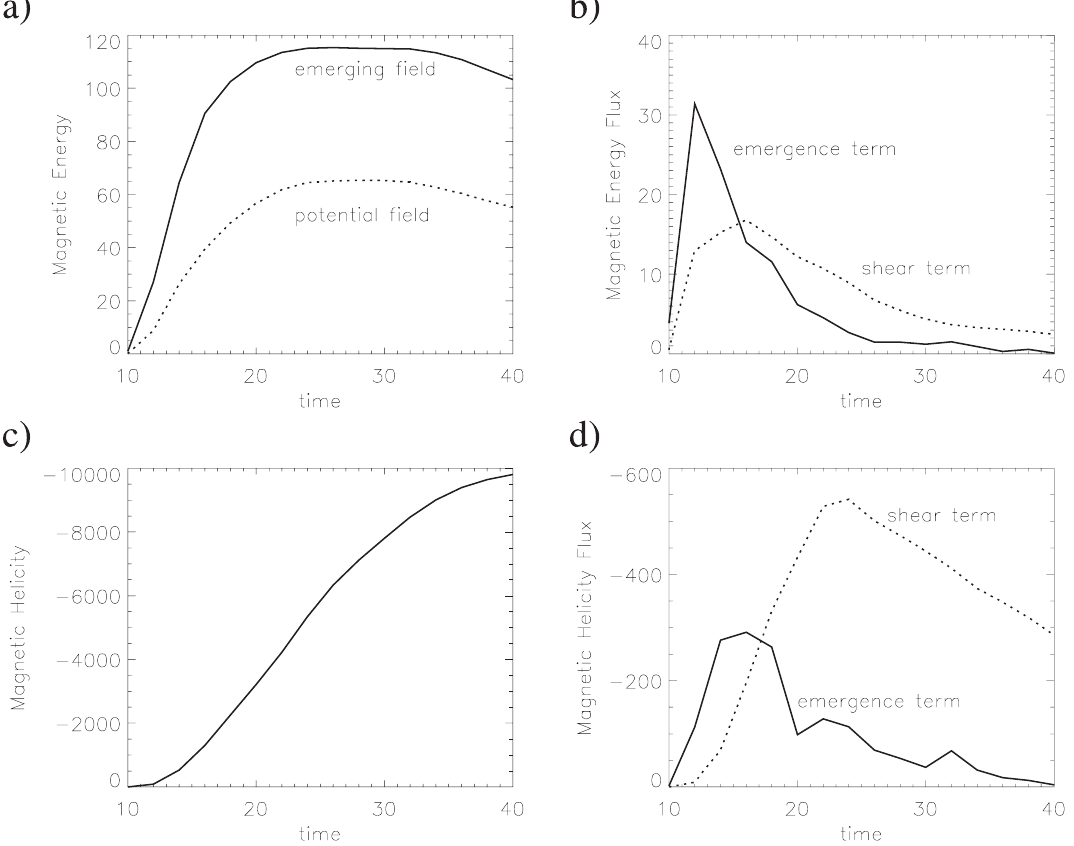
Figure 43: Time profiles of the magnetic energies and relative magnetic helicity as well as their fluxes as computed at the photospheric surface from a 3D numerical simulation of the emergence of a twisted flux tube. Image reproduced with permission from Magara and Longcope (2003), copyright by